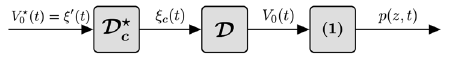
ð t Þ ¼ n 0 ð t Þ and the acoustic 0